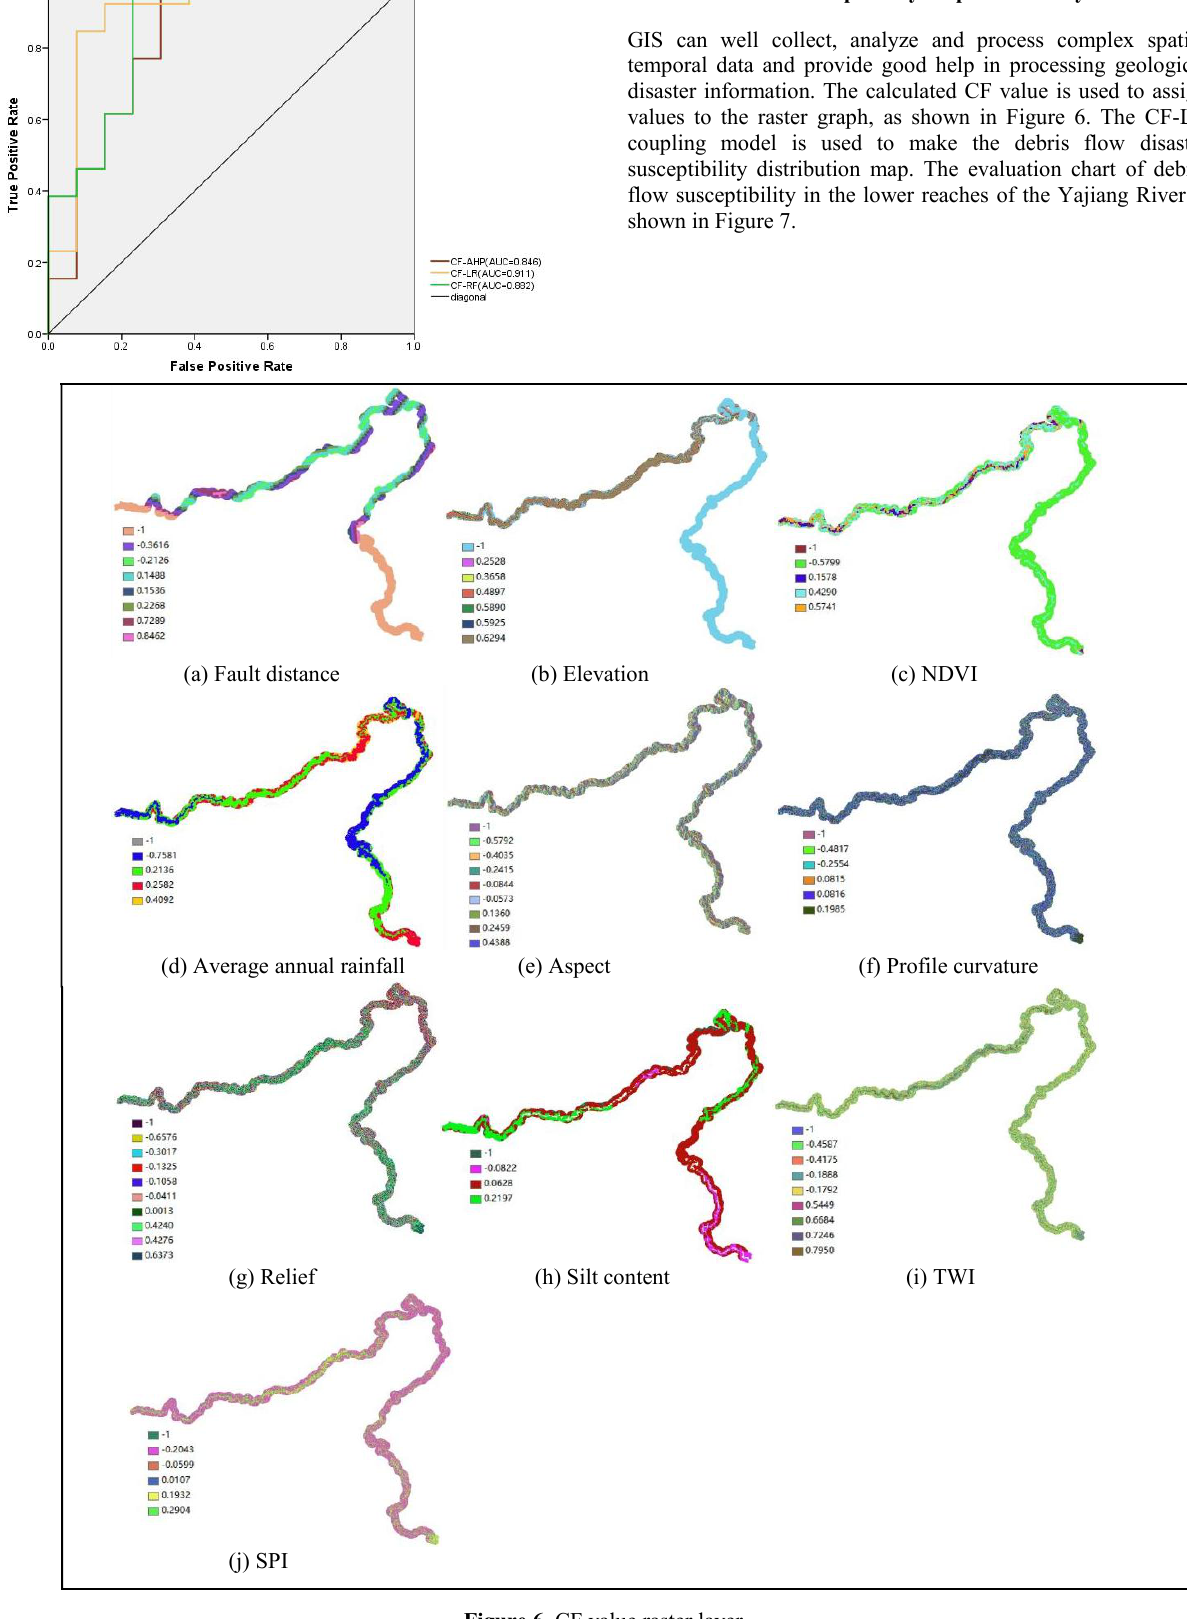
Figure 6 . CF value raster